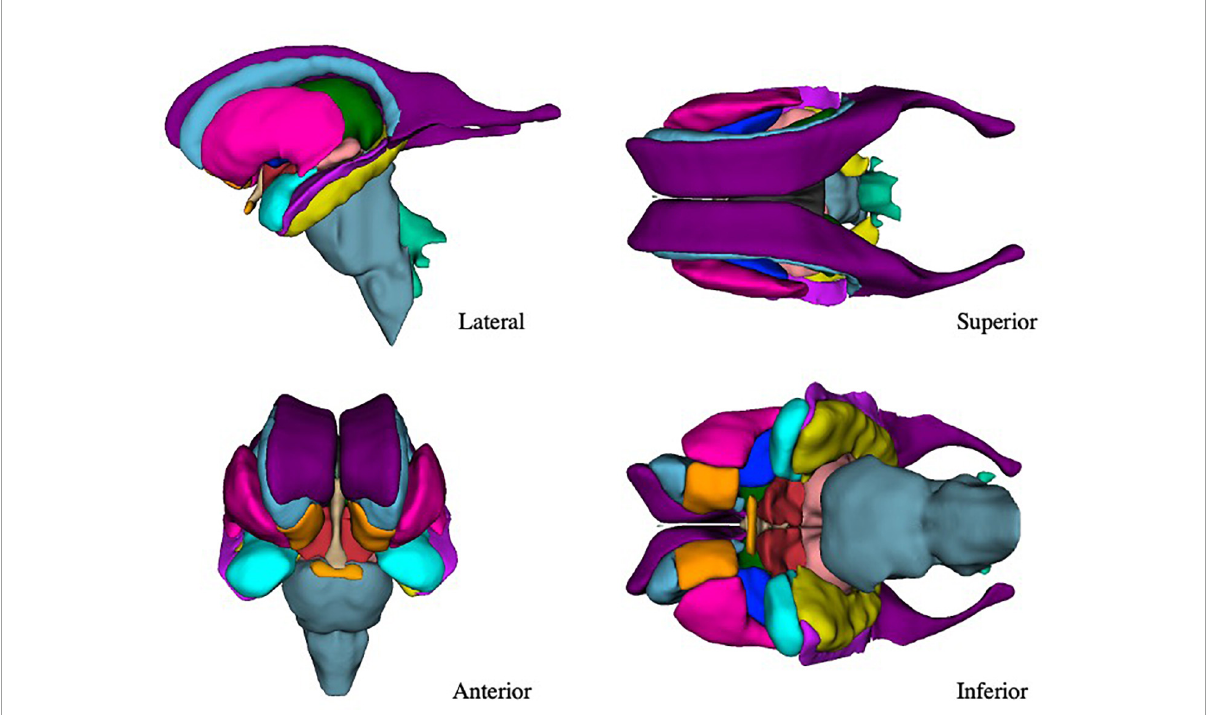
FIGURE7 Three-dimensional view of the subcortical regions of interest (ROIs) from the lateral, anterior, superior, and inferior perspectives. Purple–lateral ventricle, beige–third ventricle, aqua–fourth ventricle, light green–fifth ventricle, orange–nucleus accumbens, blue–caudate nucleus, pink–putamen, dark blue–globus pallidus, blue-gray–brainstem, green–thalamus, red–anterior ventral diencephalon, light red–posterior ventral diencephalon, light purple–inferior horn of the lateral ventricle, yellow–hippocampal formation, light blue–amygdala, light orange–optic